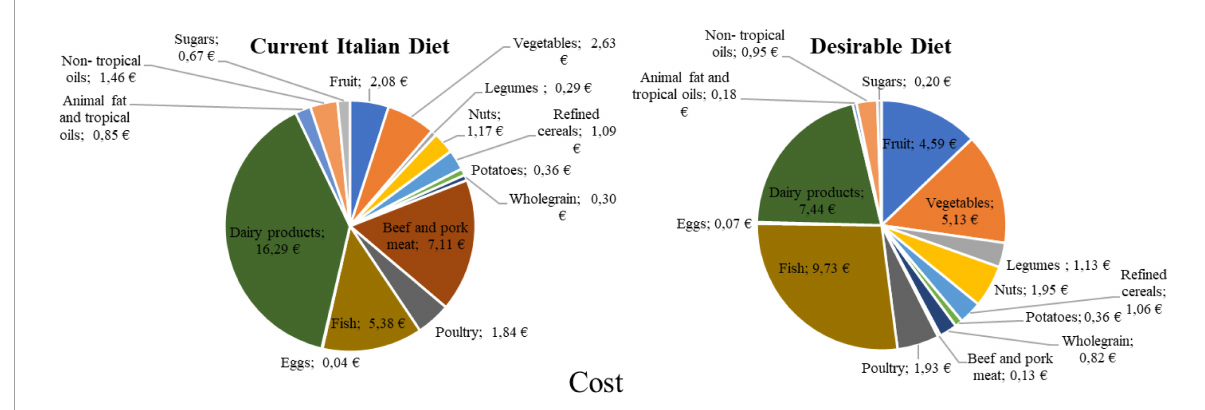
FIGURE4 Weekly cost of foods consumed in the desirable and in the current Italian diet.